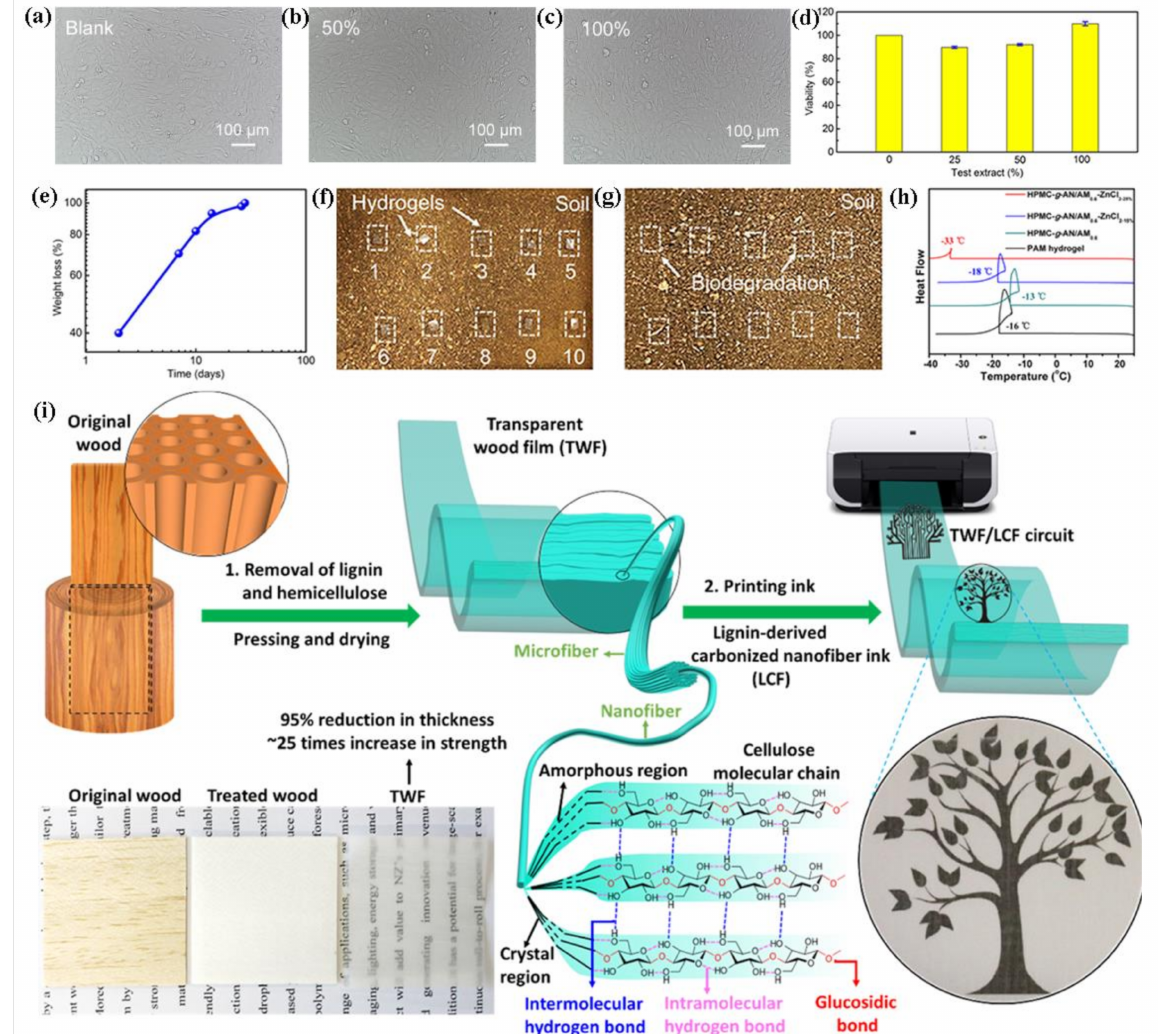
Figure 7. ( a – c ) Optical micrographs of NIH3T3 cells exposed to blank, 50% and 100% of hydrogel extract, ( d ) Viability of NIH3T3 cells after incubating with hydrogel extracted DMEM at different concentration, ( e ) weight loss of okara hydrogels during degradation time, pieces of okara cellulose hydrogels in the soil on the first day ( f ) and day 28 ( g ) in the biodegradable test. Reproduced with permission from [69]. Copyright 2019, Nature Publishing Group; ( h ) The DSC curves of the PAM, HPMC- g -AN/AM 0.6 , HPMC- g -AN/AM 0.6 -ZnCl 2–15% , and HPMC- g -AN/AM 0.6 -ZnCl 2–25% hydrogel at the temperature range from 25 ◦ C to 40 ◦ C. Reproduced with permission from [70]. Copyright 2020, American Chemical Society; ( i ) illustration processing of TWF for flexible electronics application [73]. Reproduced with permission from ref.